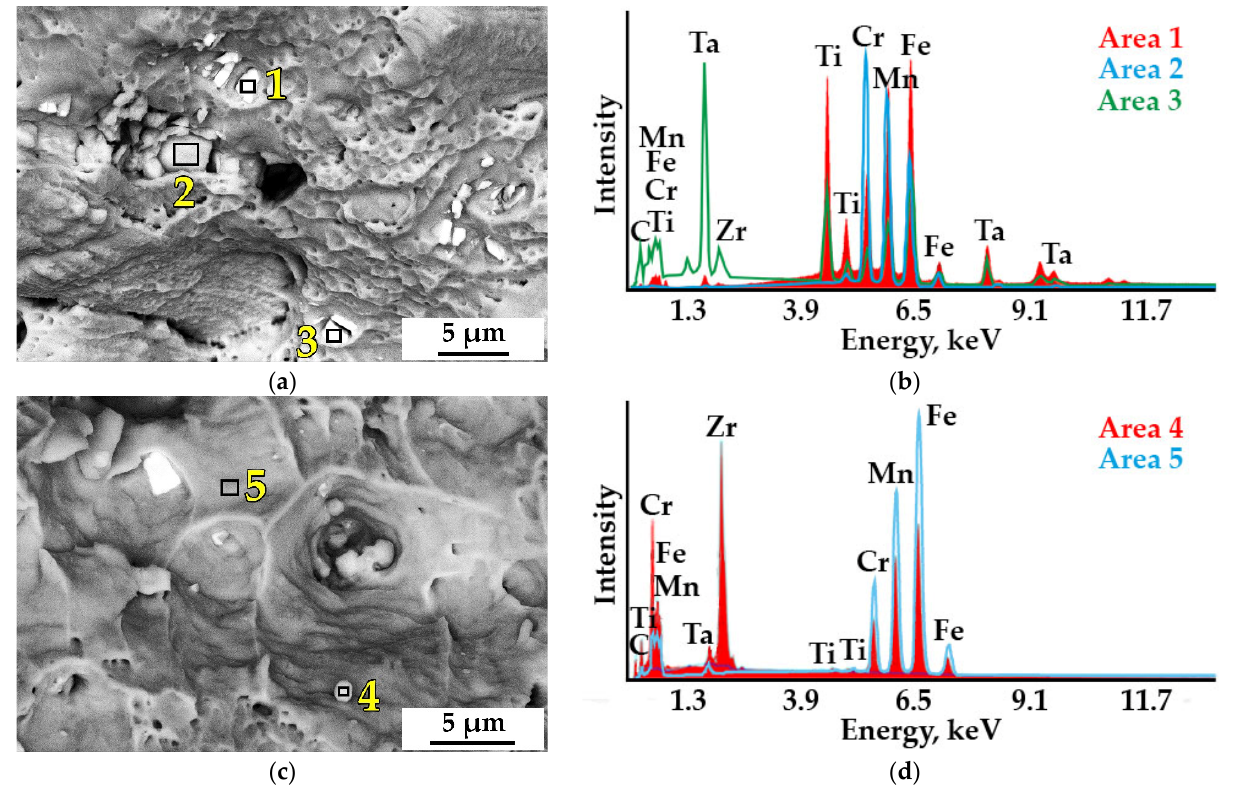
Figure 11. Dimple fracture with second phase particles of the steel tensile samples, fractured at 20 °C ( a ) and 650 °C ( c ), and corresponding EDX spectra ( b , d ) from areas 1–5. Area 5 corresponds to the matrix phase.